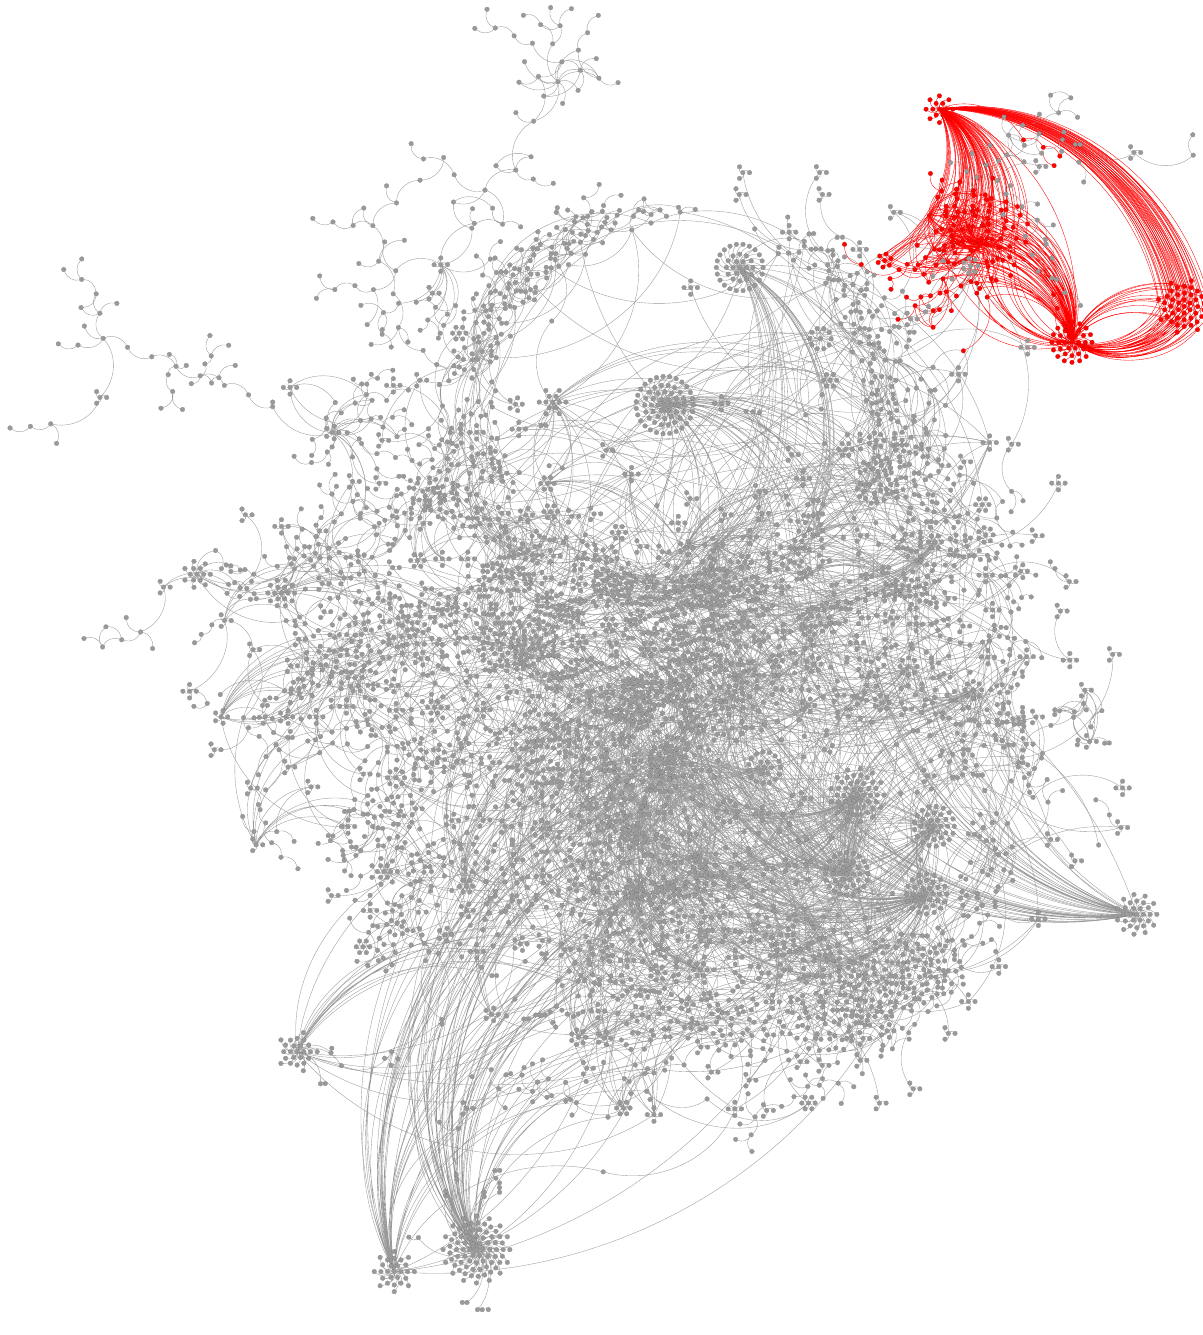
Figure 8. Local community (red) detected in the YouTube social network using the proposed method. Here we show only 5846 nodes among the total 1,134,890 nodes (about 0.5% fraction) that are most close to the seed